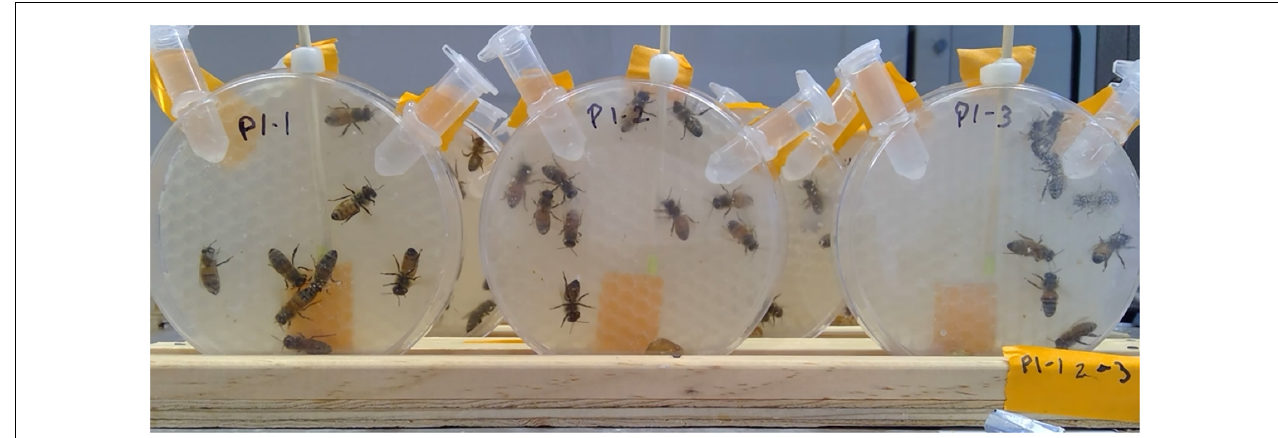
FIGURE 1 | Petri dish cages with Apis mellifera workers approximately 8 days after adult eclosion inside heated PCR cabinet. Workers were exposed during larval development to IGDs. This image was taken prior to recording worker responses to queen pheromone. Coded labels correspond to treatment and hive.